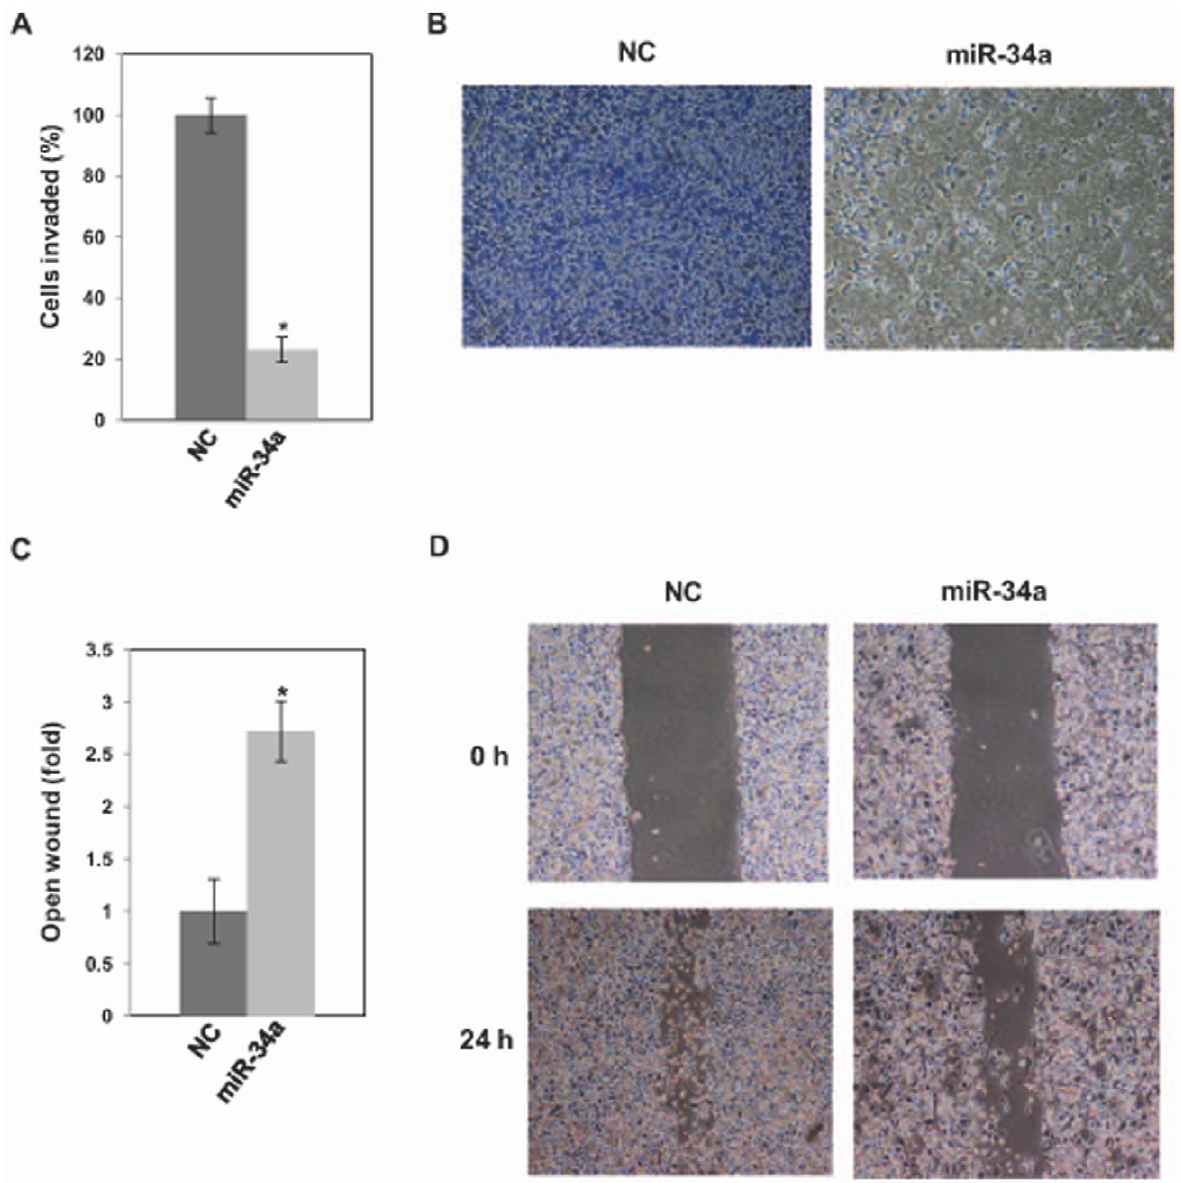
Figure 2. miR-34a inhibits invasion and migration of PC-3 cells. (A) miR-34a inhibits invasion of PC-3 cells. PC-3 cells were transiently transfected with pre-miR negative control (NC) or pre–miR-34a for 48 h. The cells were harvested and subjected to transwell invasion assay. The values are normalized to those of NC. *, P , 0.05 compared with control. (B) Representative images of the invaded cells. (C) miR-34a inhibits wound- healing of PC-3 cells. PC-3 cells were transiently transfected with pre-miR negative control (NC) or pre–miR-34a for 48 h. The cells were harvested and subjected to wound-healing assay. The width of the remaining open wound calculated in relation to separation at time 0 h. *, P , 0.05 compared with control. (D) Representative images of the wound healing